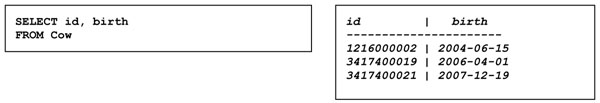
Query to get some columns and all rows of the Cow table